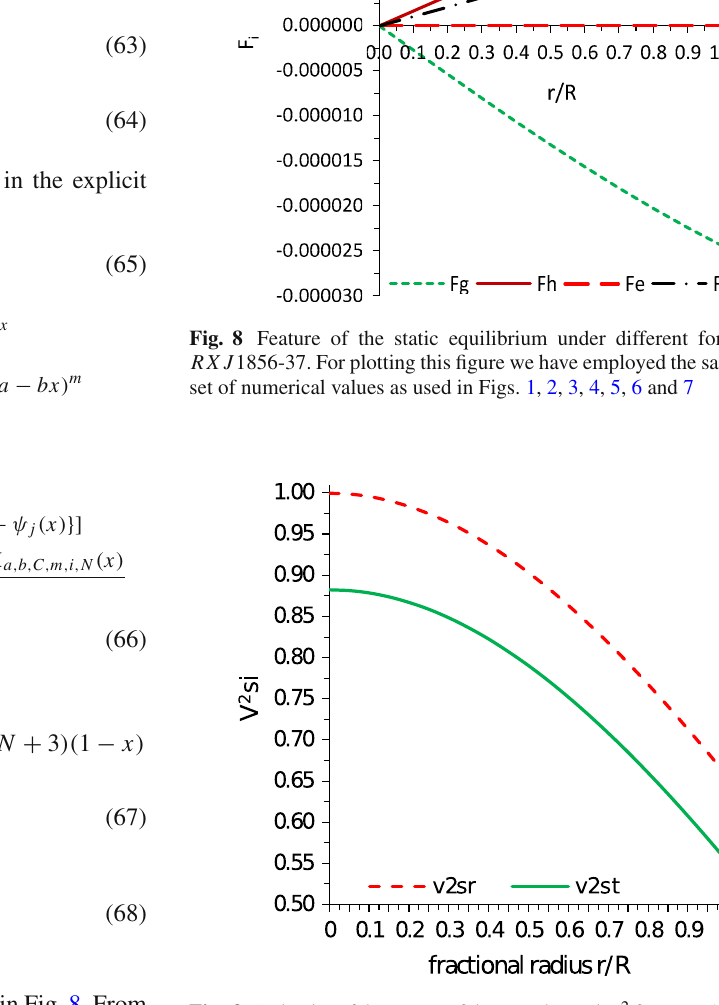
Fig. 9 Behaviorofthesquareofthesoundspeed V 2 for RX J 1856-37. Forplottingthisfigurewehaveemployedthesamedatasetofnumerical values as used in Figs. 1, 2, 3, 4, 5, 6, 7 and